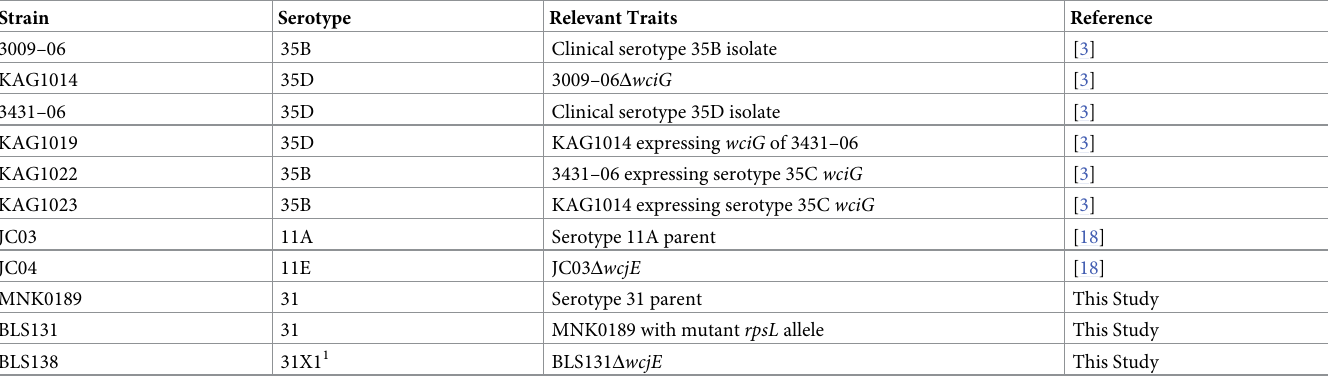
Table 1. Pneumococcal strains used in this